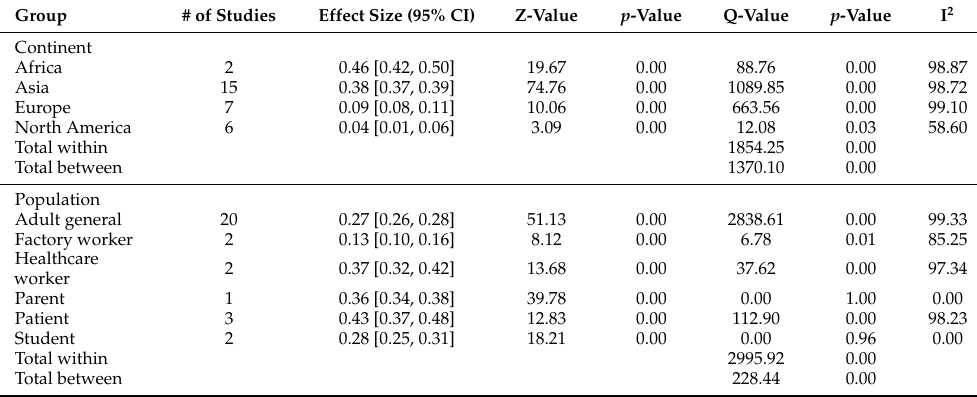
Table 5. The Meta-analysis Results of Subgroup Analyses